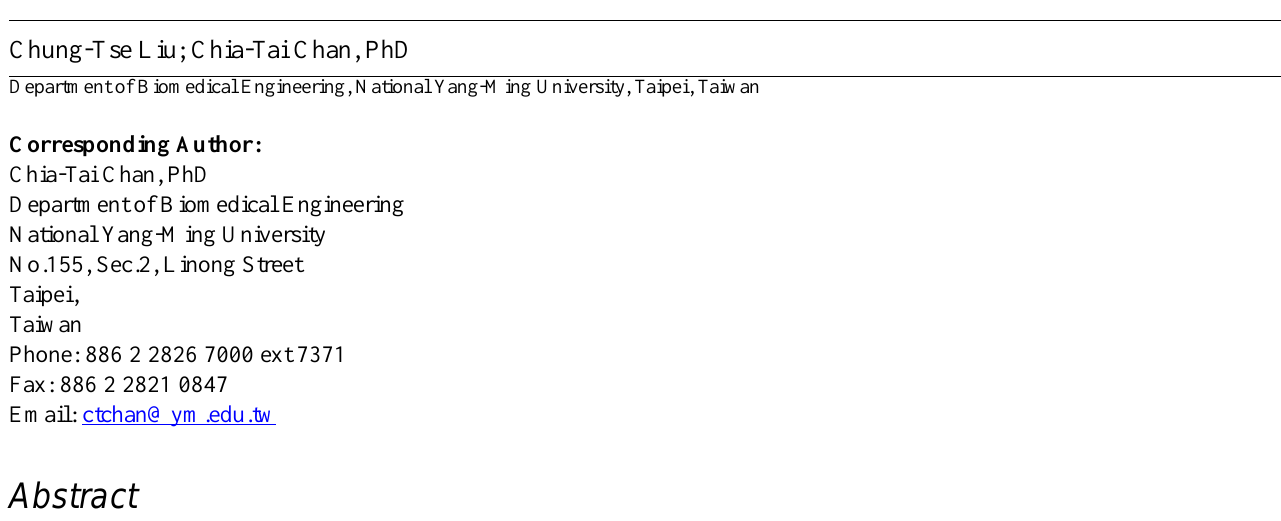
accumulated activity effective index (AAEI); physical activity; activity